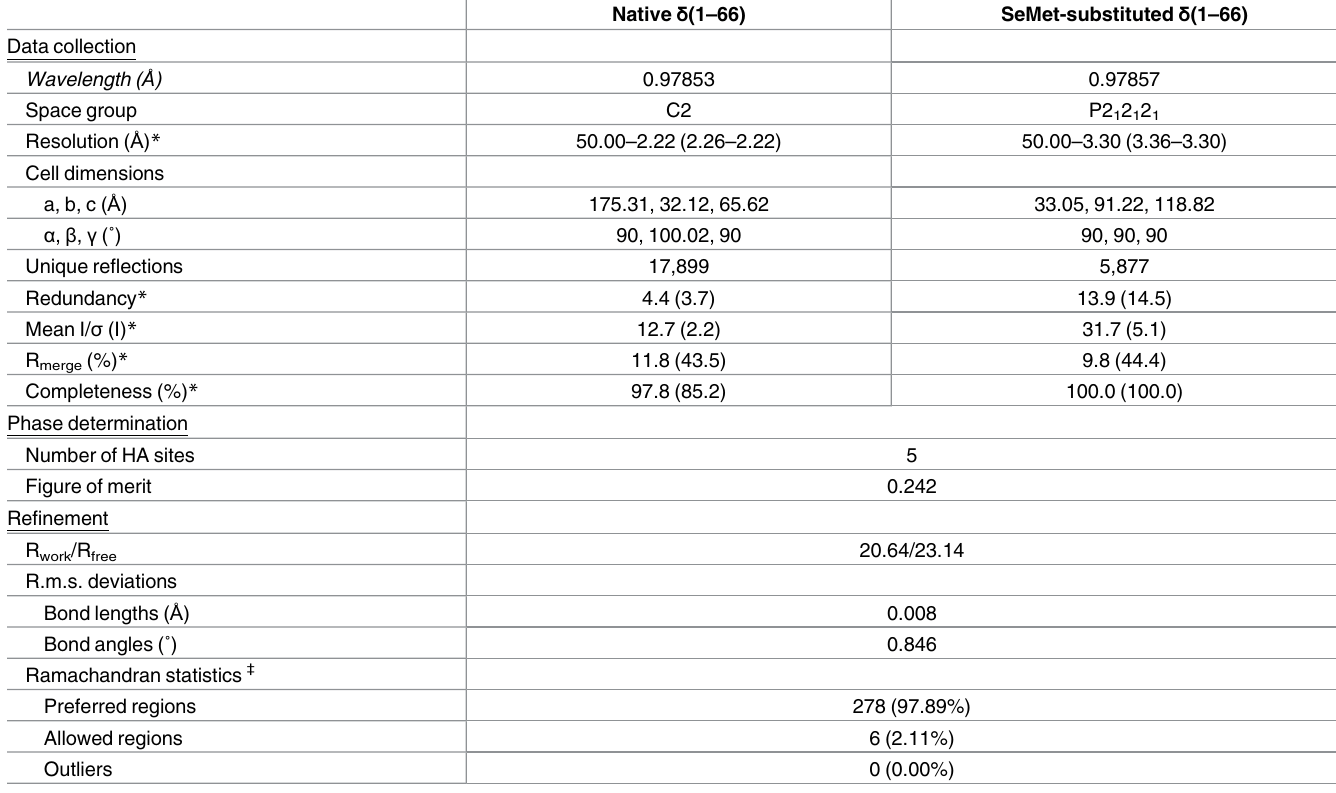
Table 1. Crystallographic